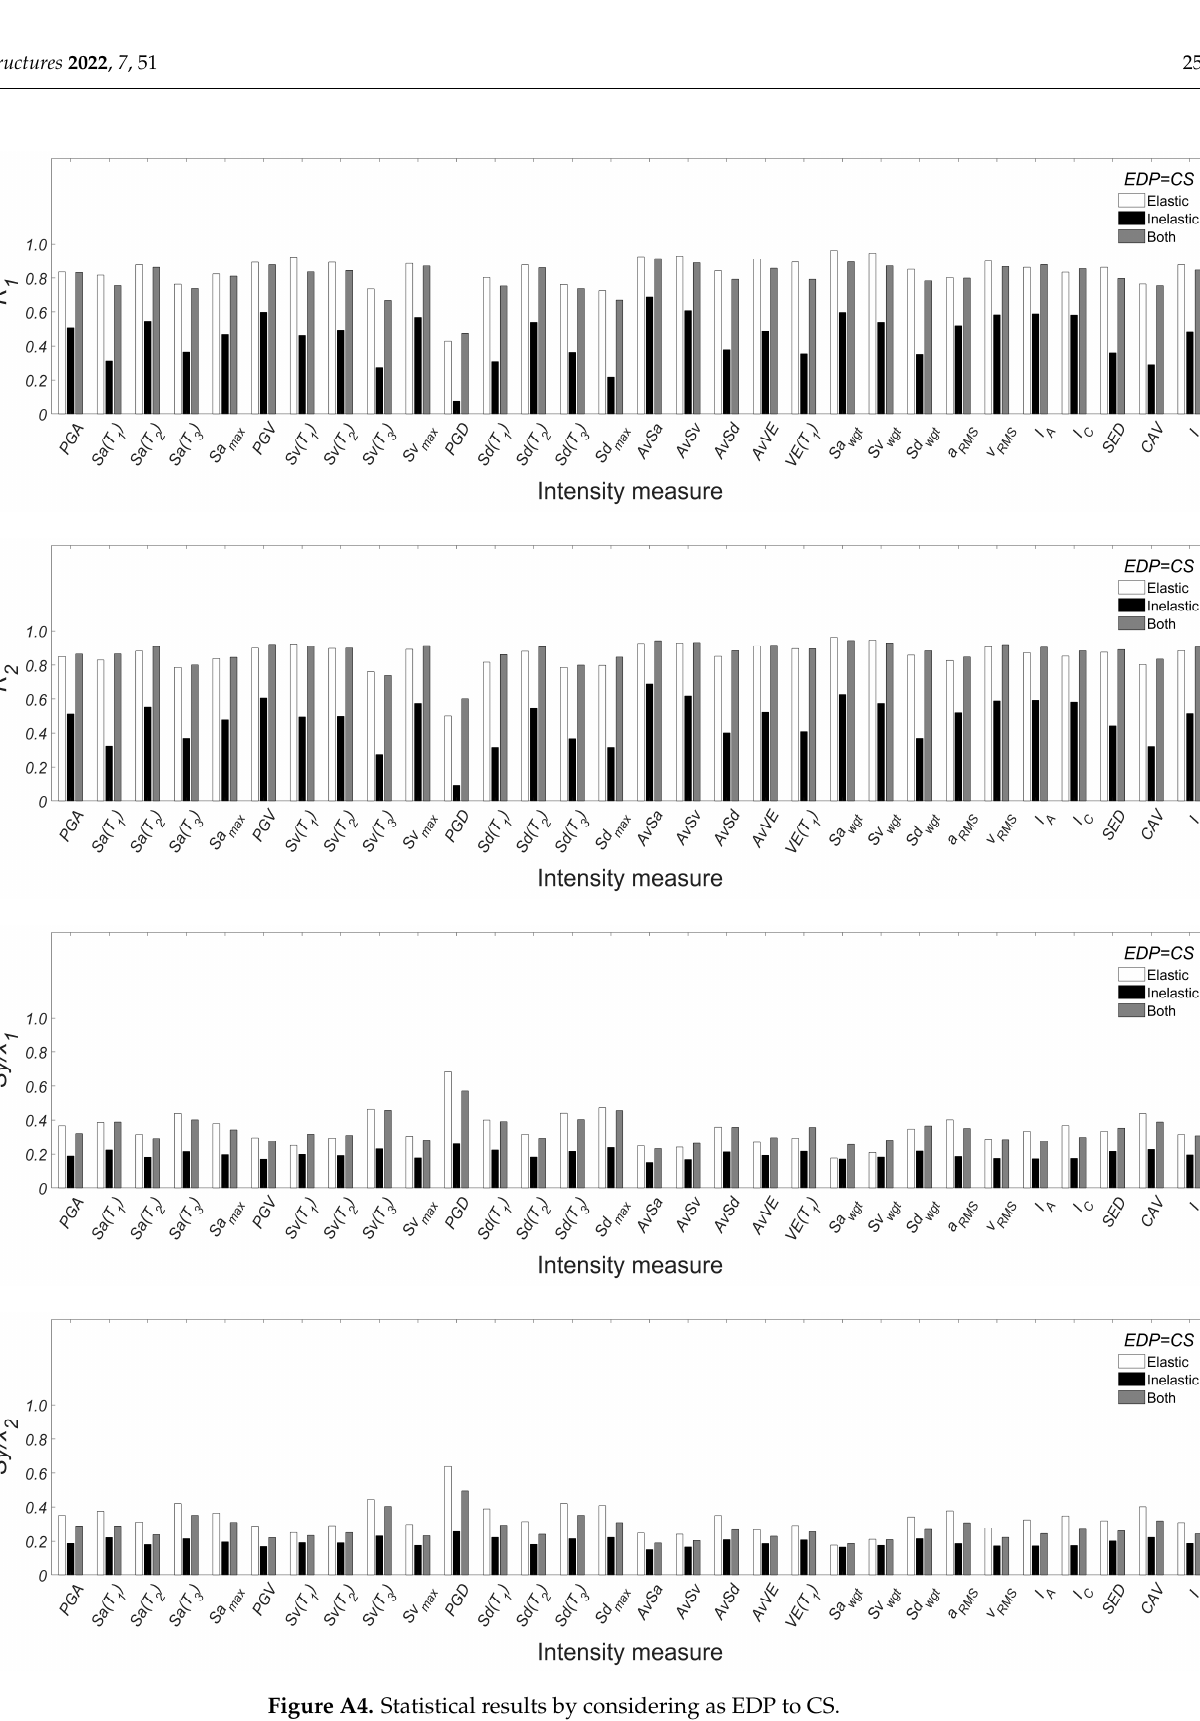
Figure A4. Statistical results by considering as EDP to CS.